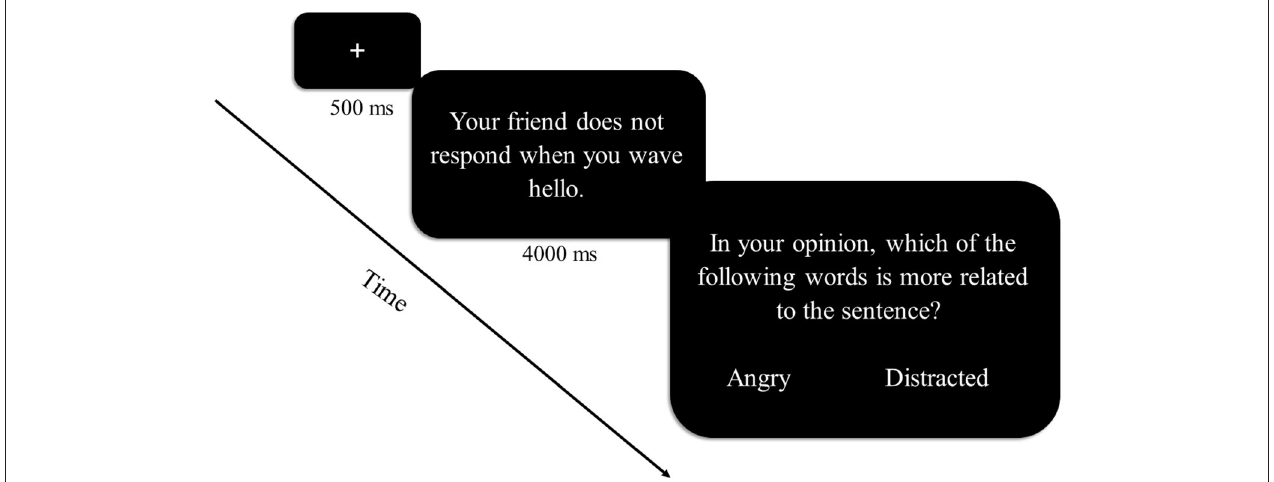
FIGURE 1 | Sequence of a typical trial in the interpretation task. The sequence of a typical trial in the interpretation task is represented graphically. On each trial, a fixation point is followed by an ambiguous sentence describing a situation in which another person is involved. Participants are instructed to imagine themselves in the described situation. Each sentence is followed by negative and benign associative words that may be related to the sentence. Participants are asked to choose, as rapidly as possible, which word they believe is more related to the